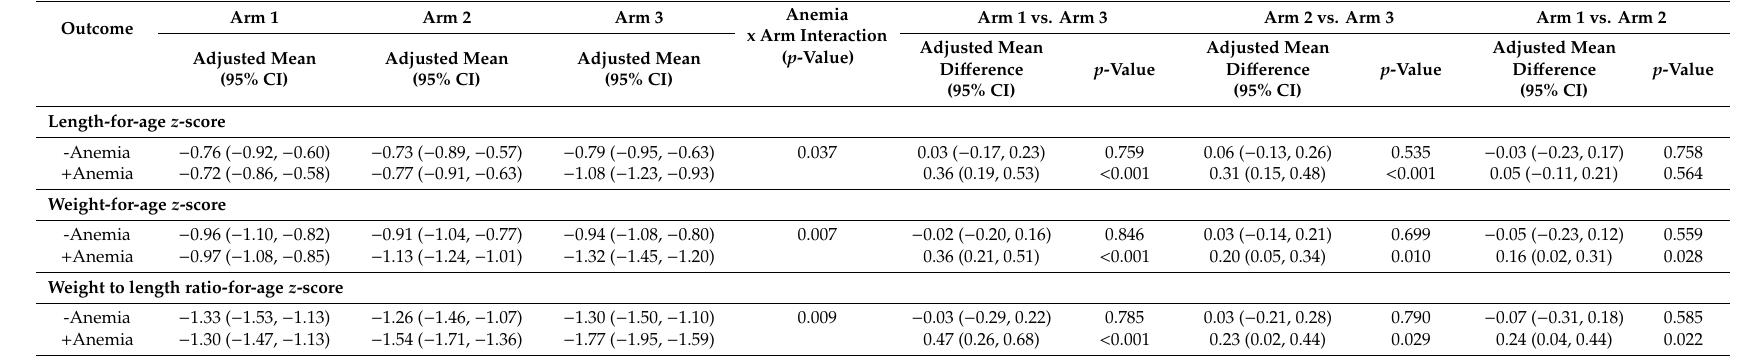
Table 5. Regression results of neonatal anthropometry by anemia: combined